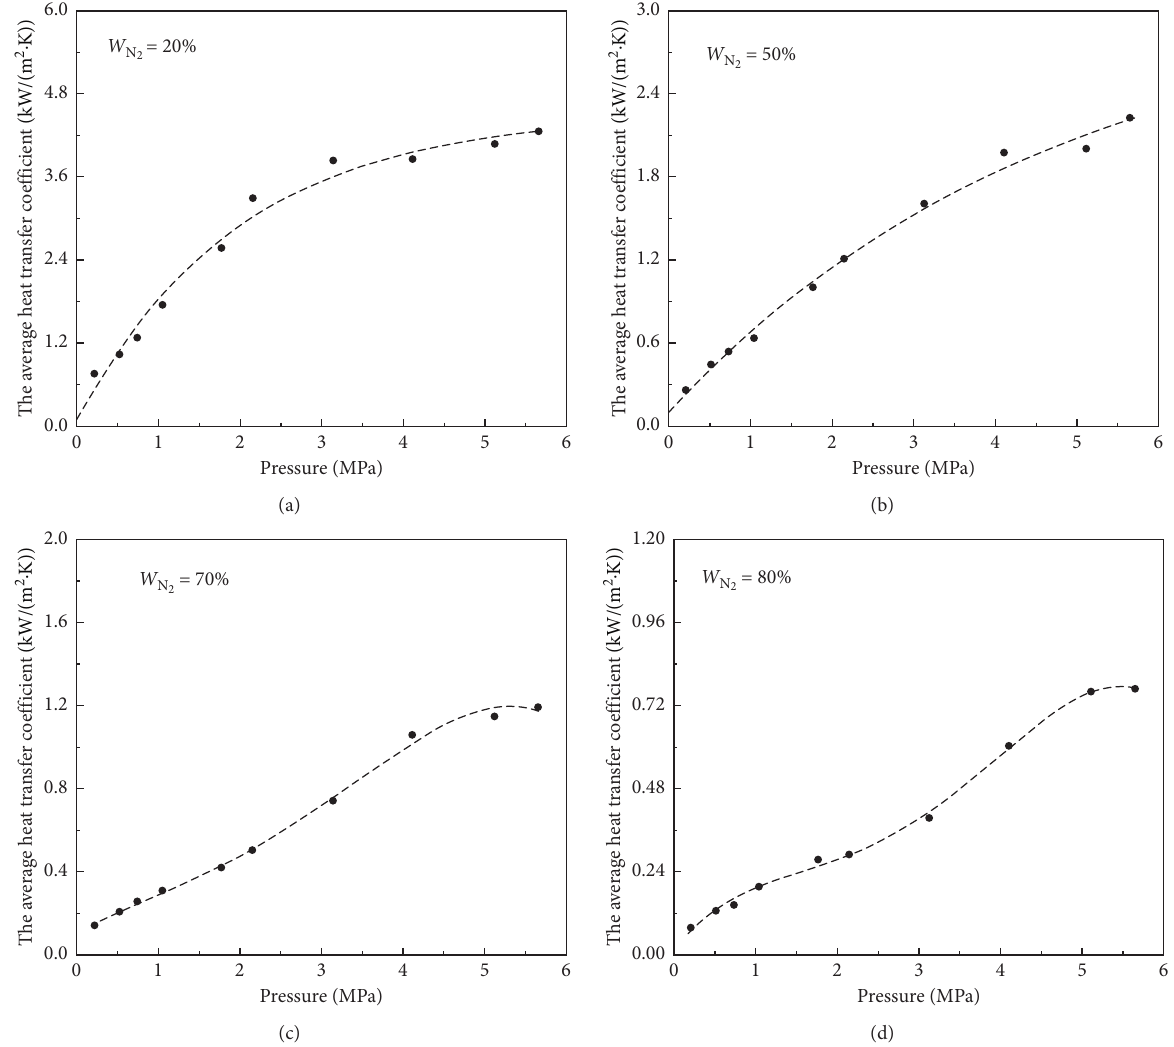
Figure 10: Effect of pressure on the steam condensation with N